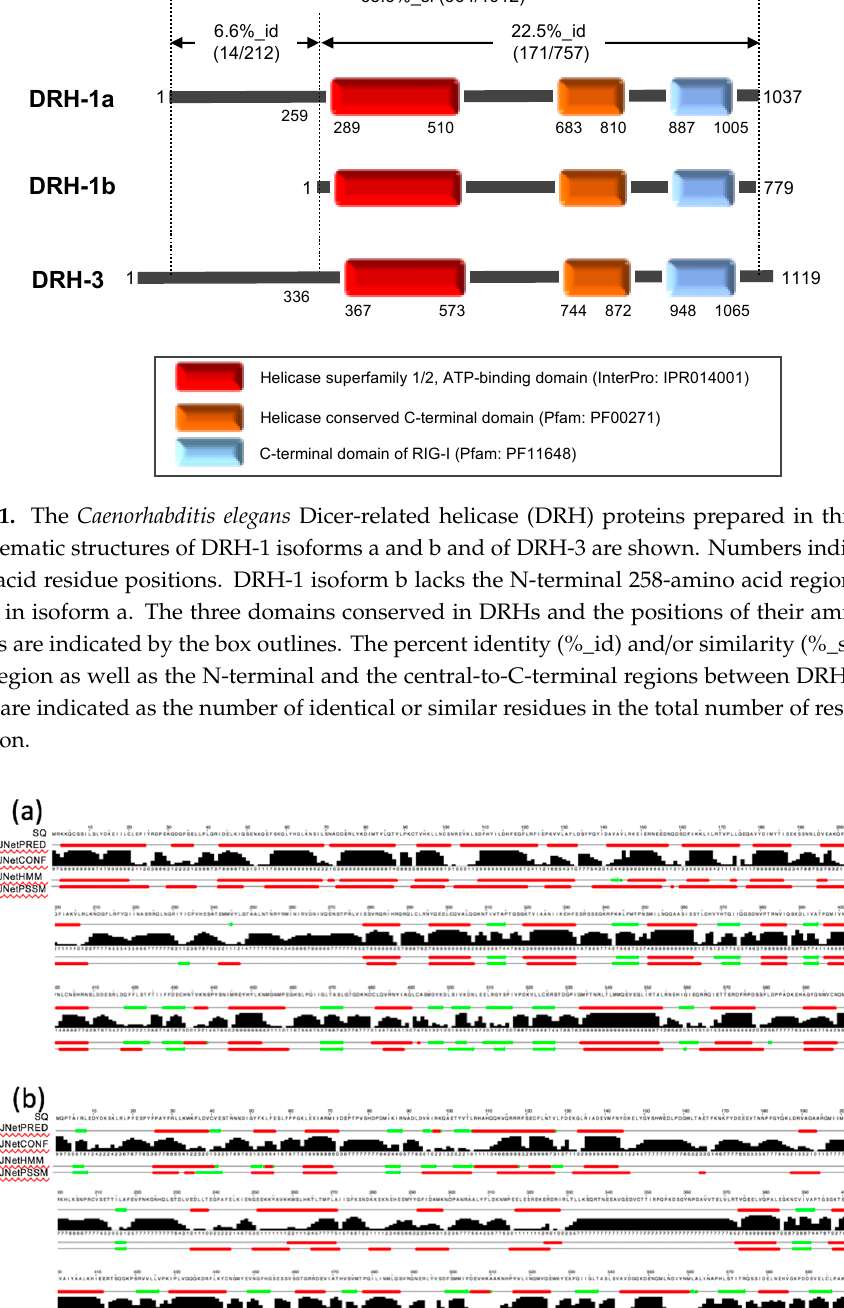
residues are indicated by the box outlines. The percent identity (%_id) and/or similarity (%_si) in the entire region as well as the N-terminal and the central-to-C-terminal regions between DRH-1a and DRH-3 are indicated as the number of identical or similar residues in the total number of residues in the region.